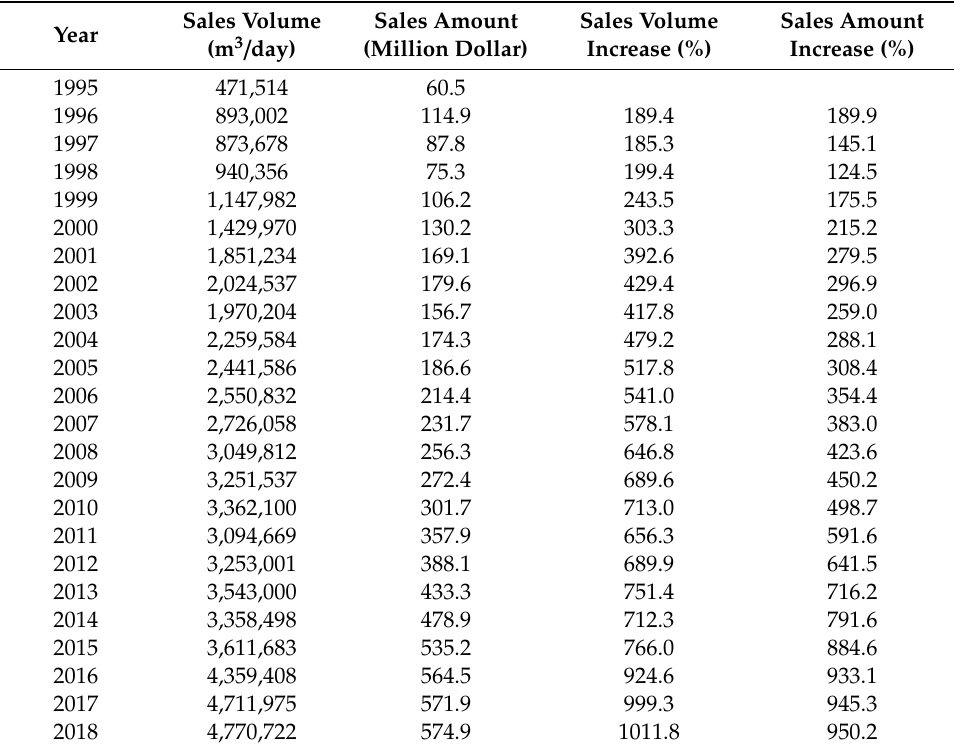
Table 4. The status of the mineral water market in South